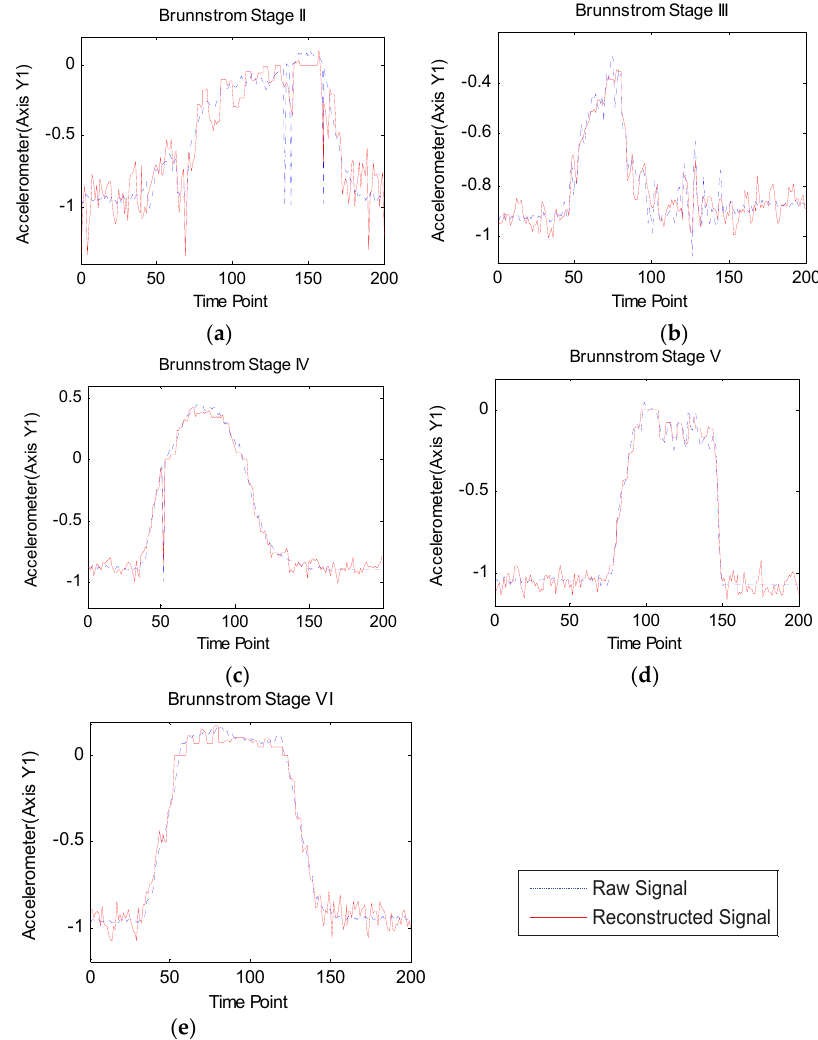
Figure 10. ( a )–( e ) Reconstructed and raw accelerometer signals from Brunnstrom stages II to VI.